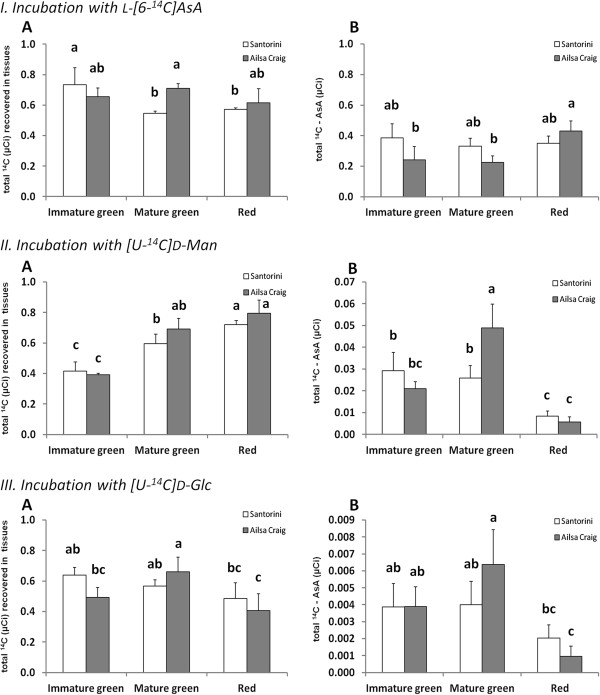
Radiolabelled feeding experiments with L-ascorbic acid (AsA) precursor substrates. Uptake and conversion of 14C in immature green, mature green and red fruit discs of ‘Santorini’ (white) and ‘Ailsa Craig’ (gray) after incubations for 24 hours with 1 μCi L-[6-14C]AsA (I), [U-14C]D-Mannose (U-14C]D-Man; II) and [U-14C]D-Glucose (U-14C]D-Glc; III). Results are represented as total radiolabel (μCi) recovered in tissues (A), and as total radiolabel (μCi) incorporated into total 14C-AsA (B). Data show the mean ± SD of three independent experiments. Different letters indicate significant differences (P < 0.05) between values based on Duncan's multiple-range-test in SAS.